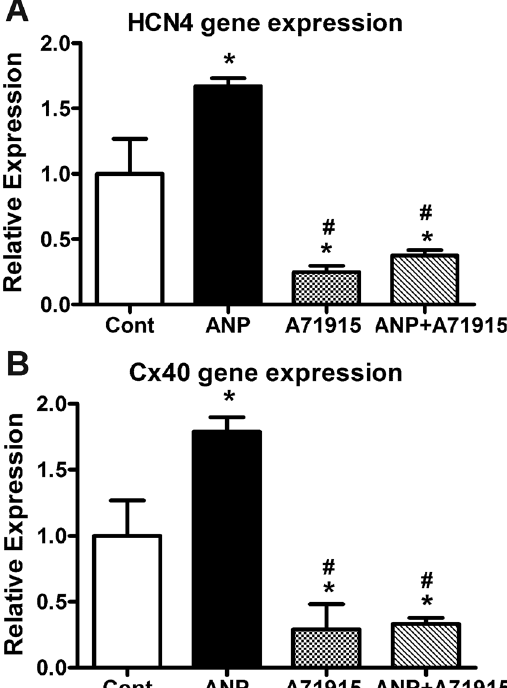
Figure 2. Gene expression of conduction system markers in E11.5 cultures treated with or without ANP and A71915. RT-qPCR analysis was used to monitor HCN4 ( A ) and Cx40 ( B ) gene expression levels in cells treated with ANP (1 μ g/ml) and or NPRA inhibitor, A71915 (1 µ M) for 48 hours. Expression levels were normalized to GAPDH via ∆∆ C T method. Relative expression levels were presented as fold changes in comparison to the levels in untreated cultures (Cont). N = 6 experiments per group, each bar represents mean ± SEM, * P < 0.05 Vs. Cont, # P < 0.005 Vs. ANP (1 μ g/ml) for both panels, One-way ANOVA with Tukey’s multiple comparisons post hoc